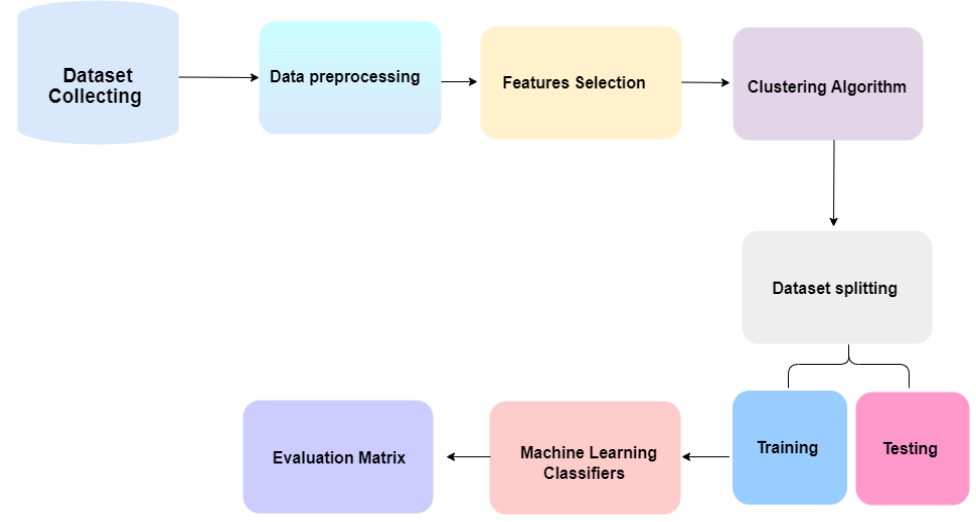
Figure 2. Architecture of the proposed methodology.